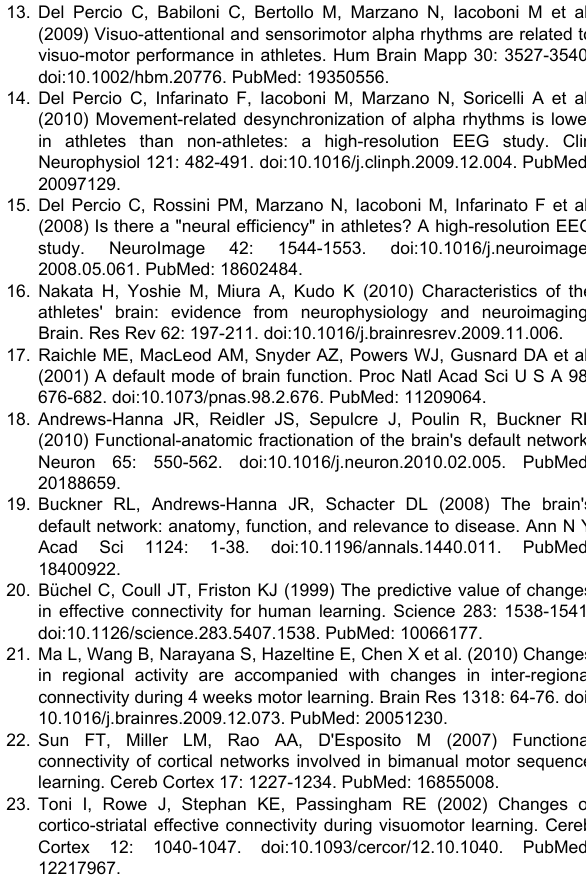
Table S3. Group mean path coefficients during motor reaction task, with prediction going from row to column. The group means in bold are significantly different from zero (p<0.05, uncorrected). Inf.Occ., inferior occipital cortex; SMA, supplementary motor area; Cereb., cerebellum.